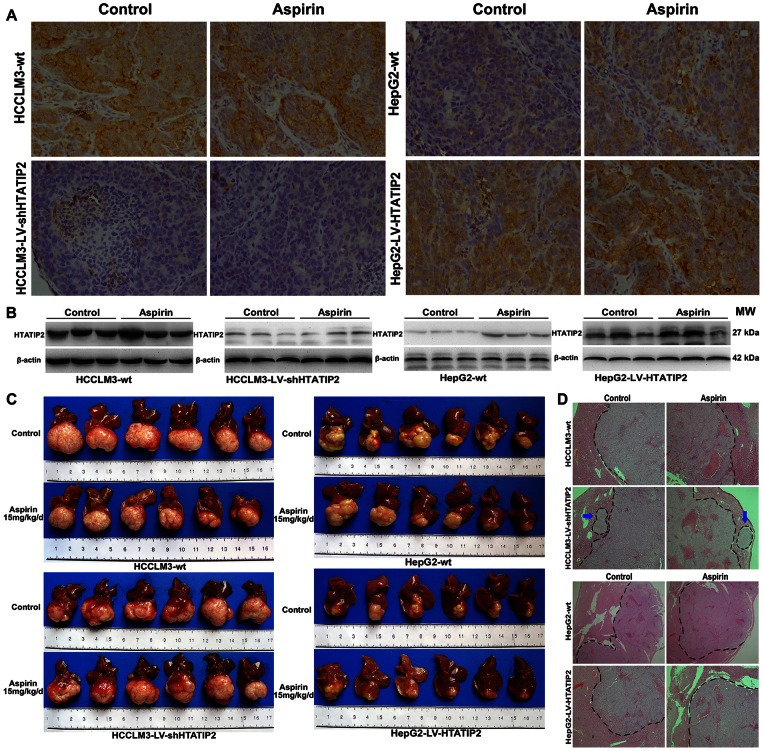
Aspirin up-regulated HTATIP2 expression and suppressed invasiveness and metastatic potential in a xenograft hepatoma model.(A, B) Expression of HTATIP2 protein was detected by immunohistochemistry (A, original magnification, ×200) and Western blotting (B). (C) In HCCLM3-wt and HCCLM3-LV-shHTAITP2 models (left panel), HTATIP2 knockdown apparently increased IHM; aspirin did not affect these 2 models. In HepG2-wt and HepG2-LV-HTATIP2 models (right panel), overexpression of HTATIP2 obviously inhibited tumor invasion. The tumor margin was clearer with aspirin treatment in the HepG2-wt model. (D) Hematoxylin-eosin staining confirmed that lower expression of HTATIP2 promoted invasiveness and metastasis potential of HCC, which could be reserved by aspirin.